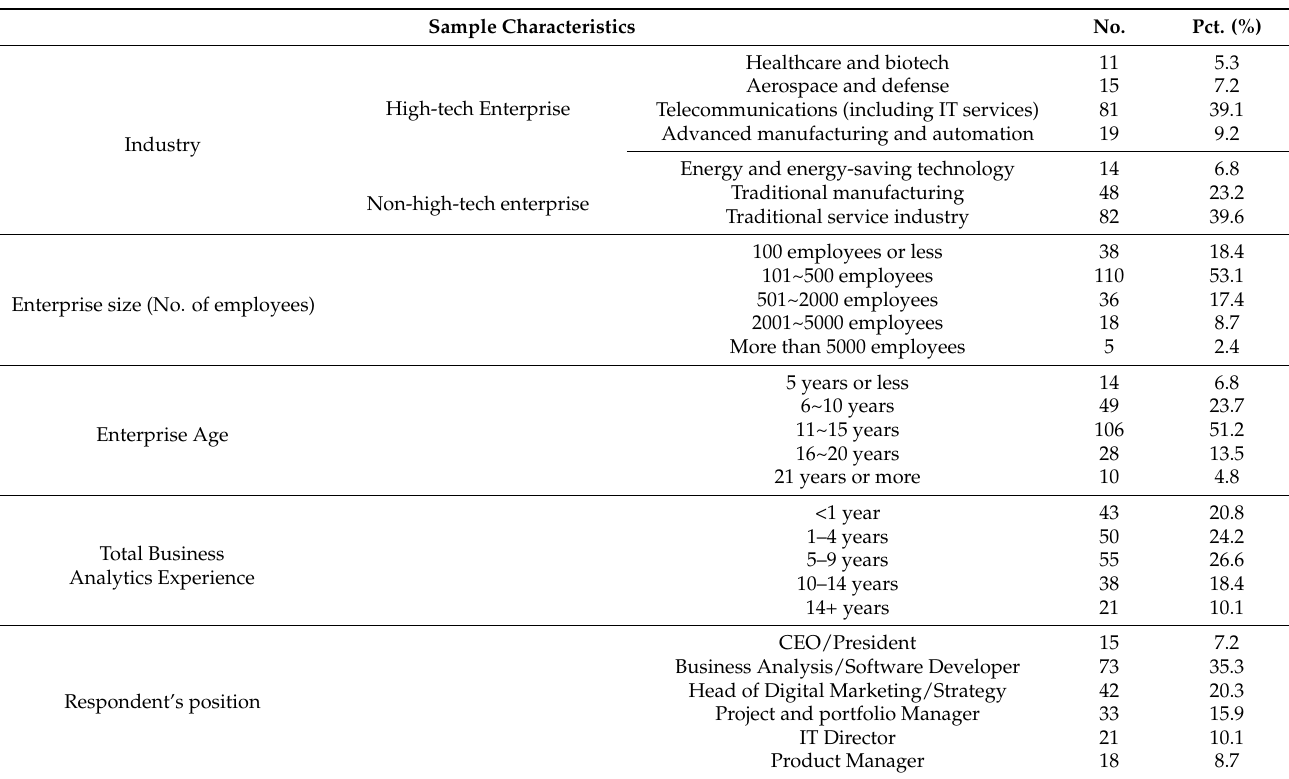
Table 1. Distribution of sample characteristics ( n =